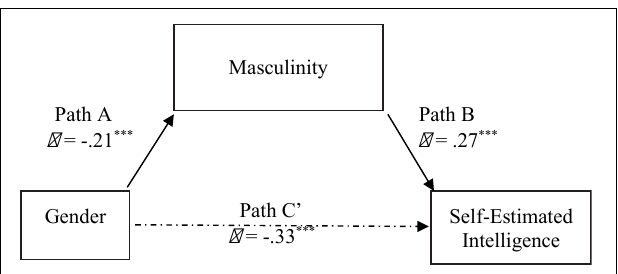
FIGURE 6 | Indirect effect of gender on SEI, with masculine sex-roles acting as a mediator on self-estimated intelligence. Path C’ represents the direct effect of gender after controlling for the mediator. *** p <